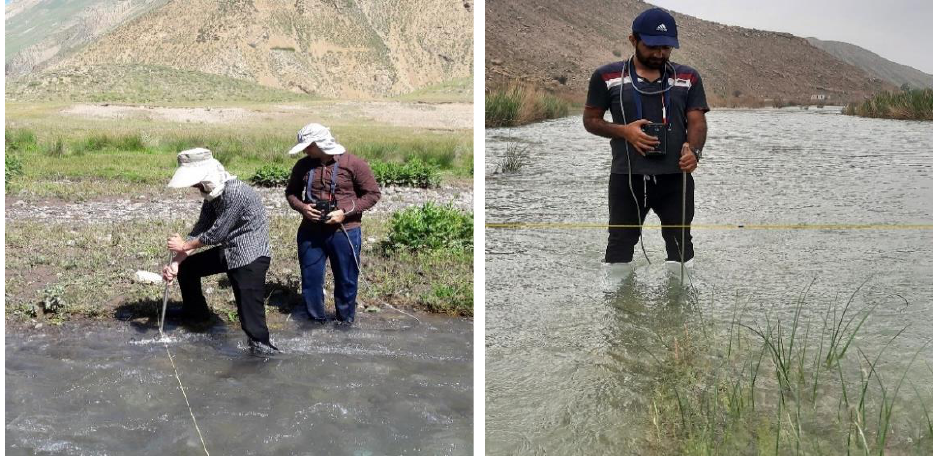
Figure 3. Velocity measurement at selected reaches. Table 3. The number of velocity measuring points in the four studied reaches.